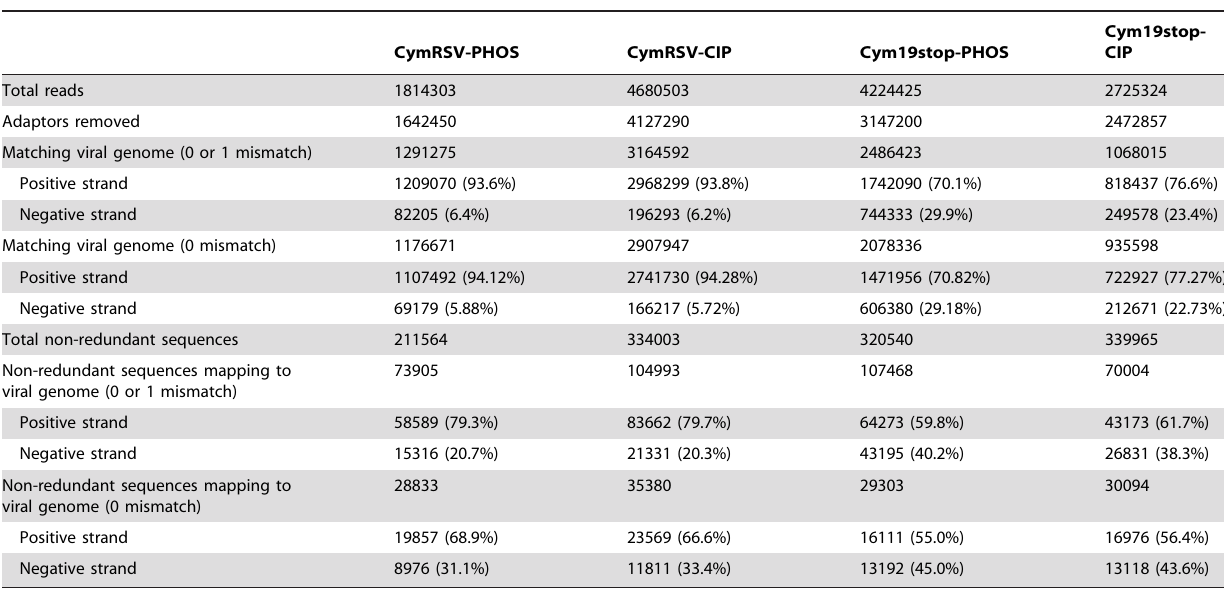
Table 2. Summary of Solexa